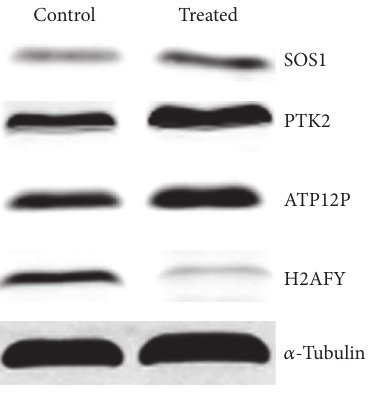
Figure 6: Protein expression analysis for four pivotal proteins including SOS1, PTK2, ATP12P, and H2AFY in GES-1 cells by Western blot. GES-1 cells were treated with deoxycholic acid. Western blot analyses were performed using whole extracts of cells treated with deoxycholic acid. 𝛼 -Tubulin was used as an endogenous